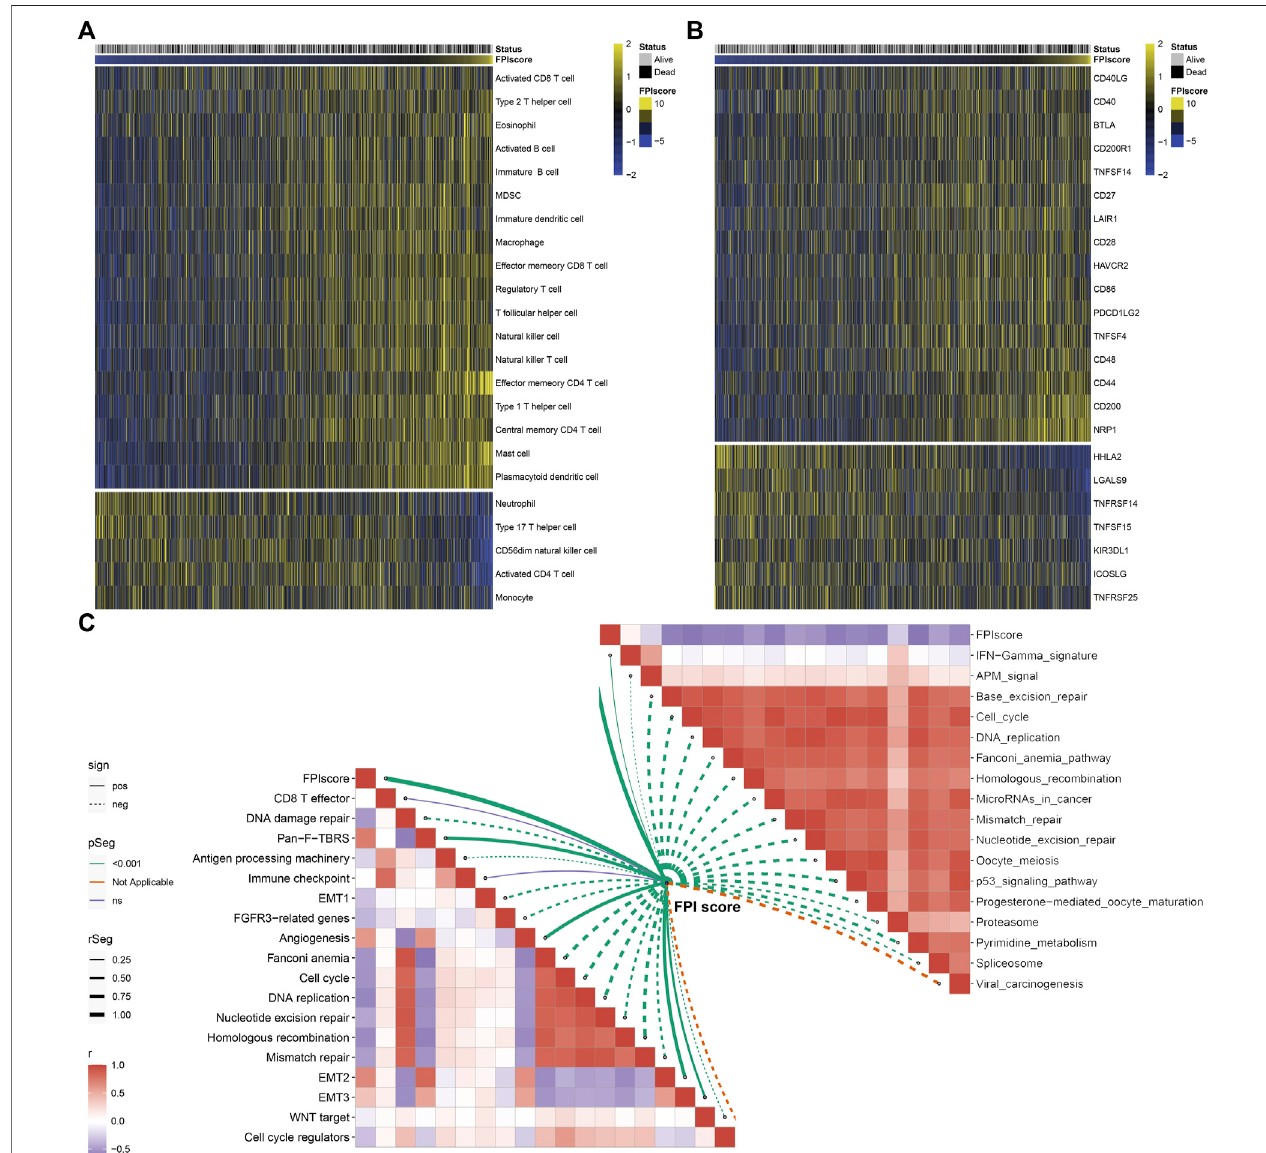
FIGURE6| AssociationbetweenFPIscoreand tumor immunityacrossGCsamples. (A) Heatmap visualizingthein fi ltration levelsoftumor-in fi ltratingimmunecells inlowandhighFPIGCsamples.Yellow,highin fi ltration;blue,lowin fi ltration. (B) HeatmapshowingthemRNAexpressionofimmunecheckpointsinlowandhighFPIGC samples. Yellow, high expression; blue, low expression. (C) Association between FPI score and known biological processes and pathways.